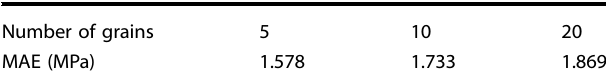
Table 1. MAE for test datasets based on 5- and 20-grain microstructures and for the training dataset based on 10-grain